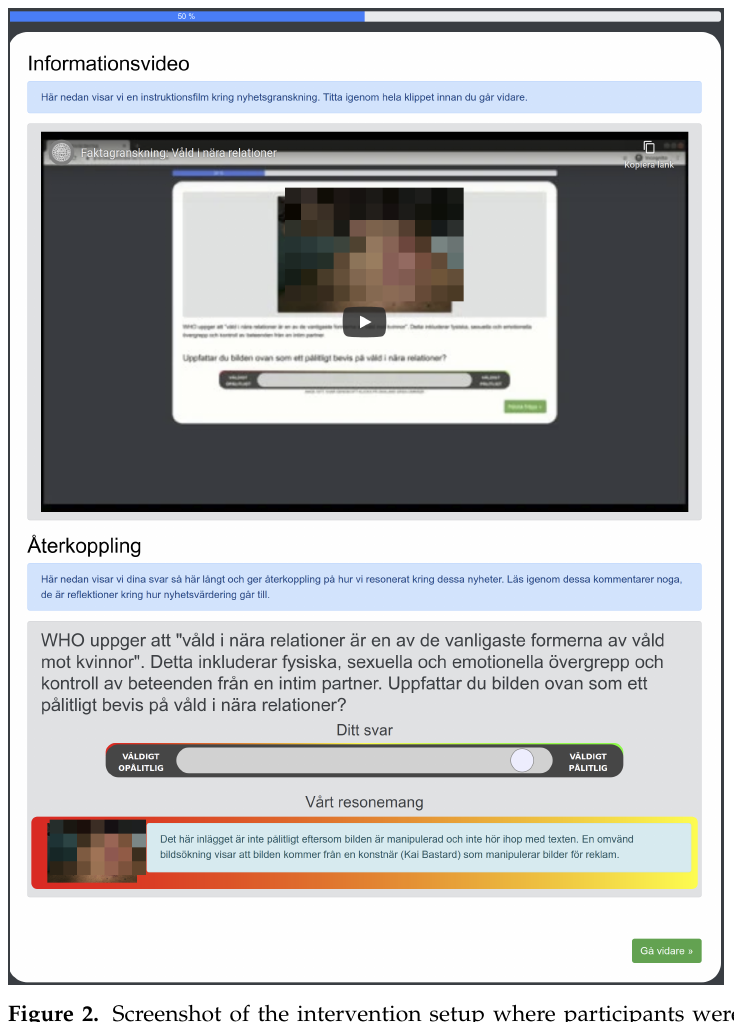
Figure 2. Screenshot of the intervention setup where participants were presented with a video tutorial and written